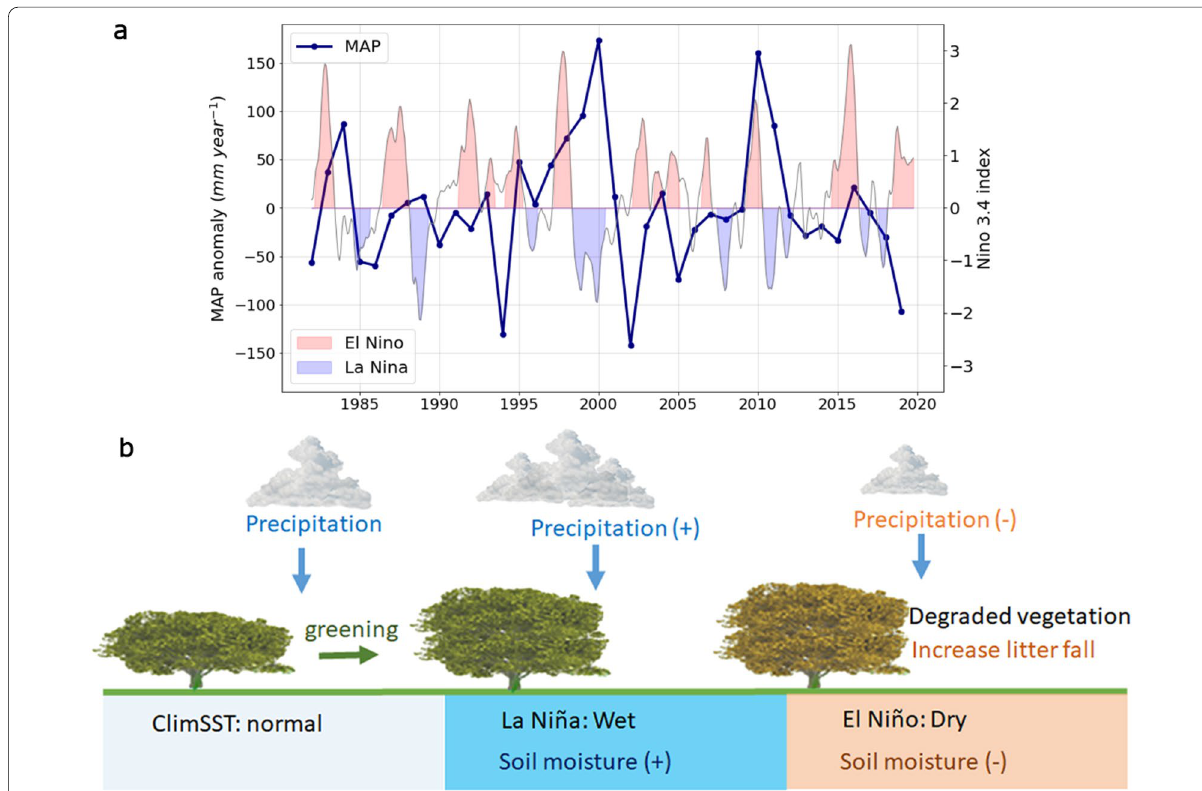
Fig. 8 The temporal variation of mean annual precipitation (MAP) anomaly for ENSO conditions. a The temporal variations of MAP anomaly were calculated as the MAP extracted from the means for the whole period of 1982–2020. The Niño3.4 index is used to identify the El Niño events (red shading) and La Niña events (blue shading). b The conceptual figure illustrates the changes in surface conditions associated with the alternating wet and dry climate variability contributed by the different SST